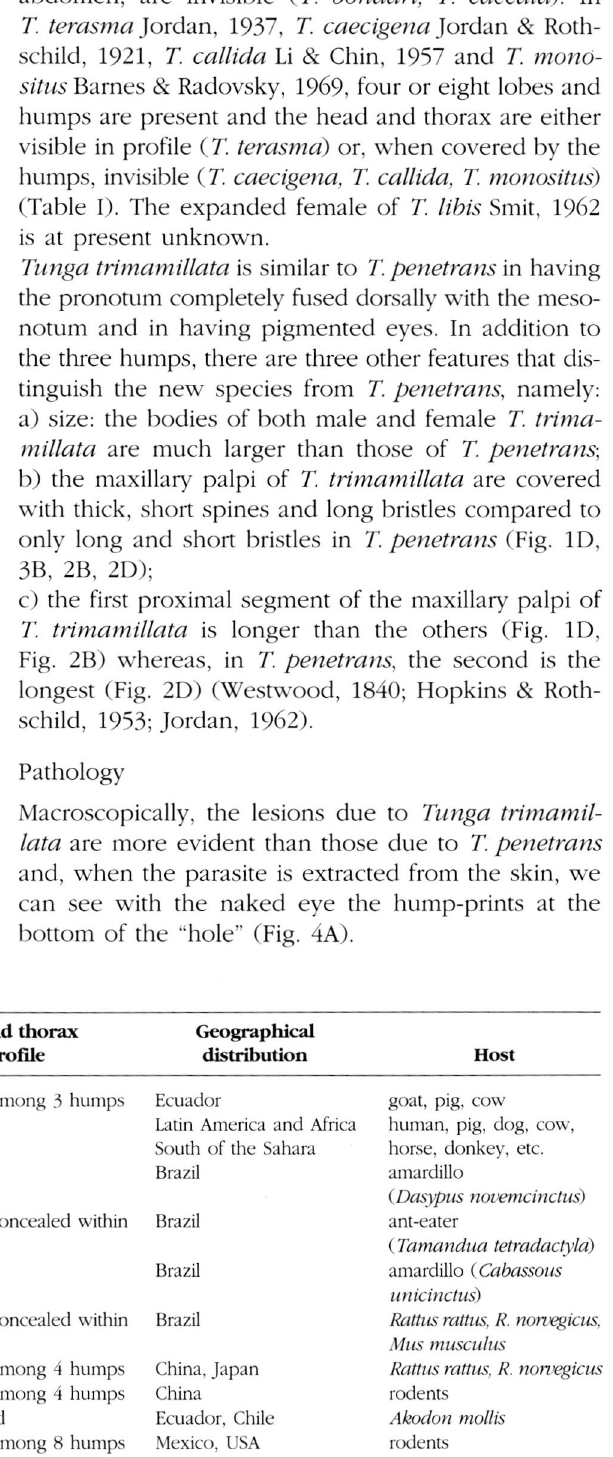
abdomen, are invisible ( T. bondari,